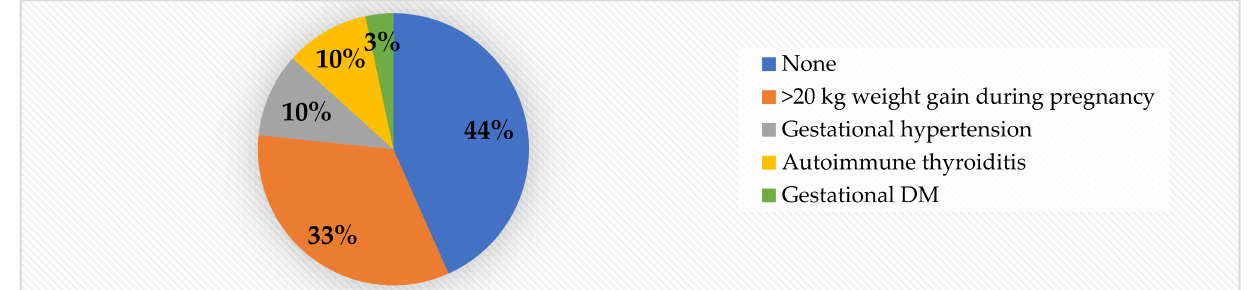
Figure 4. Mother’s health during pregnancy in obese